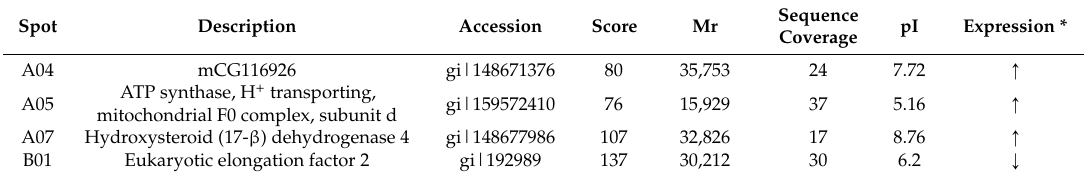
Table 1. Differentially-expressed proteins in hepatic mitochondria of mice fed a low selenium diet.